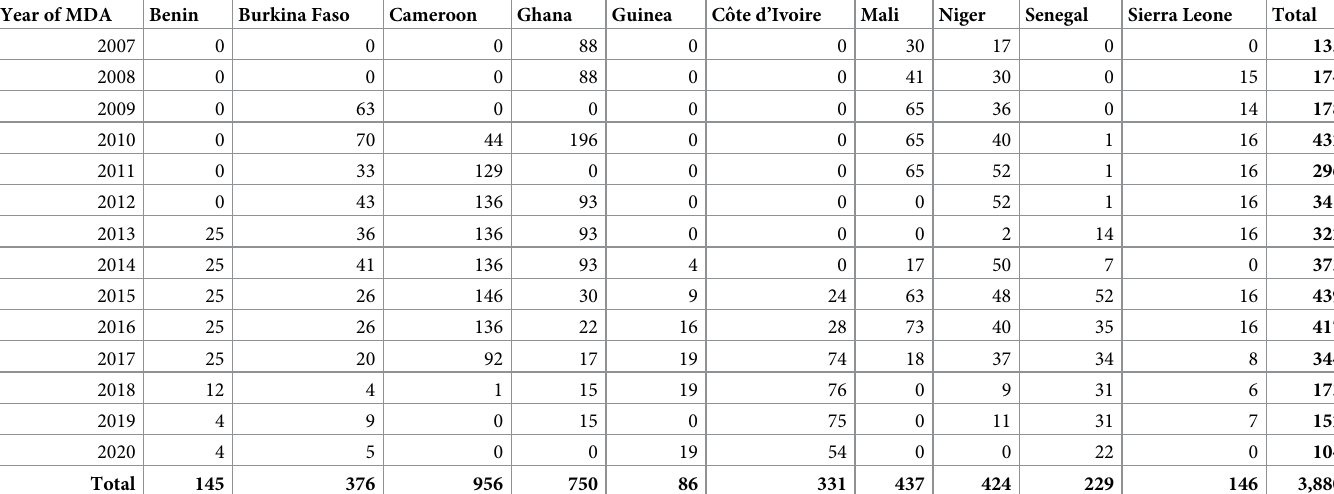
Table 2. Selected LF MDA campaigns included in analysis, by country and year, adjusted to 2021 administrative boundaries. Year of MDA